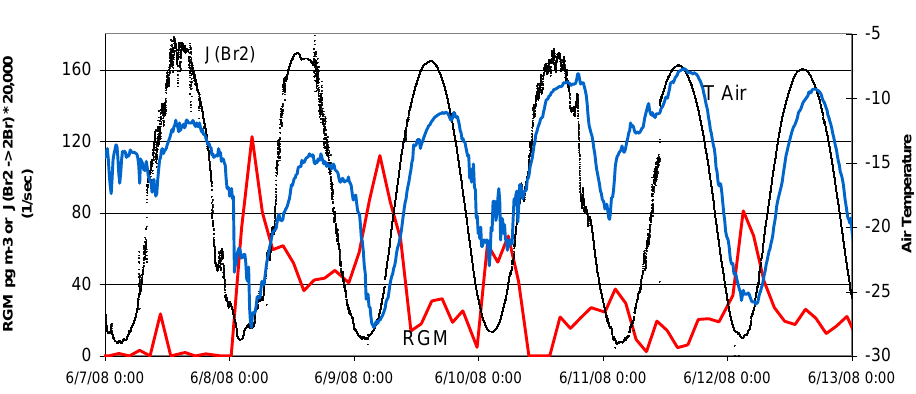
Fig. 8. Reactive gaseous mercury (RGM), J(Br 2 + hν = > 2Br), and air temperature at Summit, Greenland, 7–13 June 2008. Correlation coefficients for RGM-J(Br 2 ) and RGM-Temperature are r =− 0 . 39 and r =− 0 . 75, respectively.